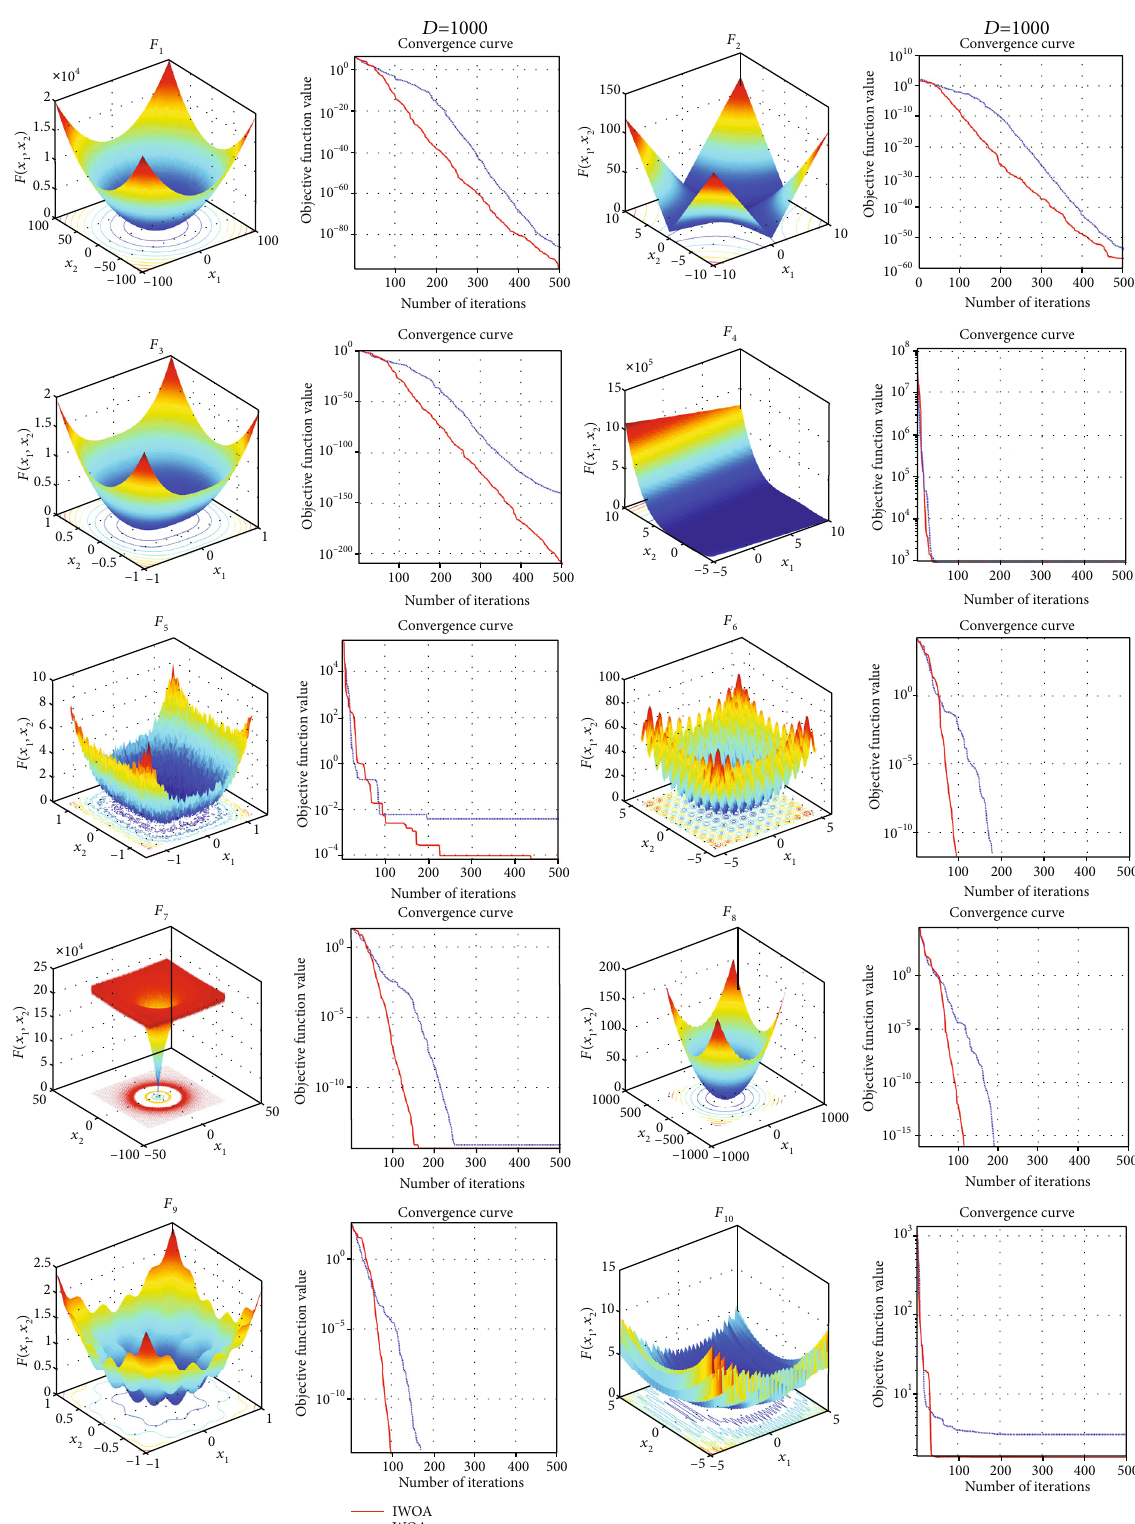
Figure 5: Comparison of convergence curves between improved WOA and